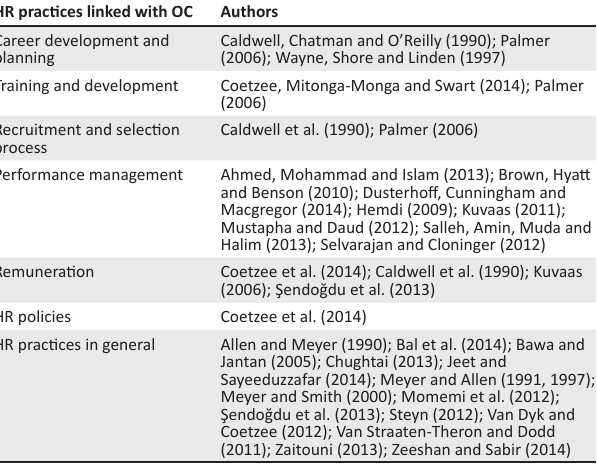
TABLE 1: Previous research between human resource practices and organisational